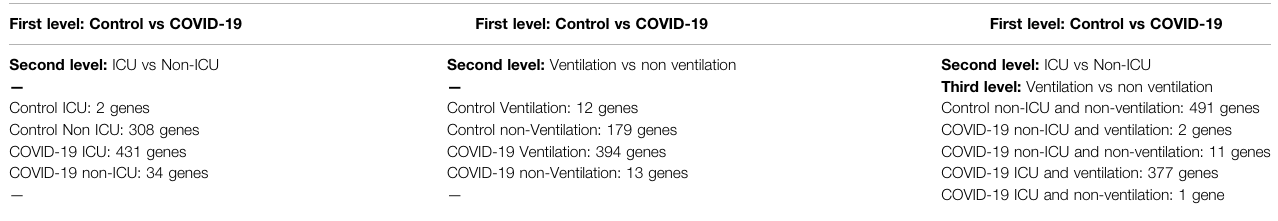
TABLE 7 | Number of differentially expressed genes in each